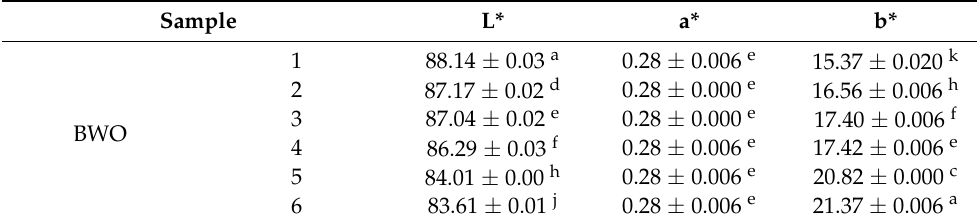
Table 6. Color values in margarines prepared with BWO and